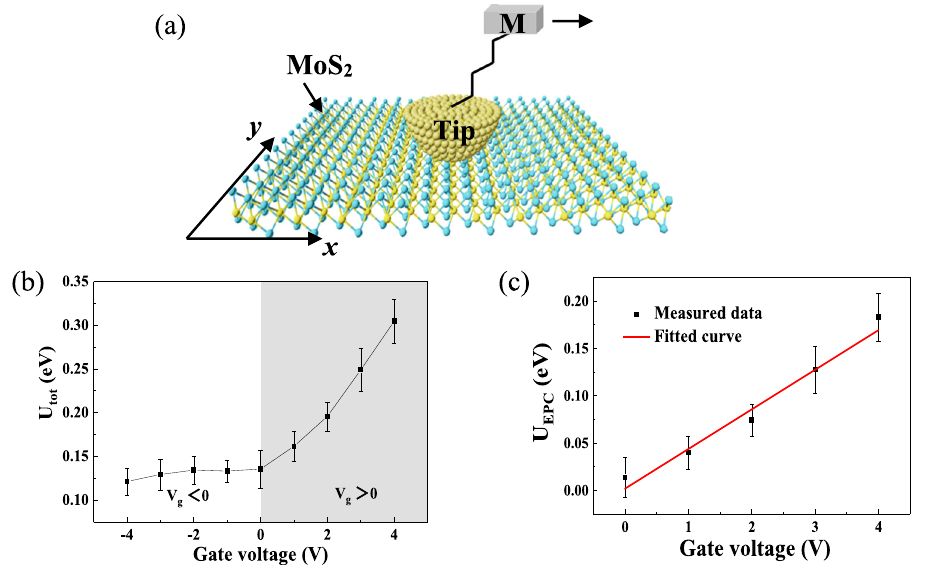
Fig. 7 Modi fi ed Prandtl − Tomlinson model and calculating of the energy corrugation. a Schematic of the modi fi ed Prandtl − Tomlinson model describing that the AFM tip moves on the monolayer MoS 2 . b Energy corrugation U tot as a function of gate voltage. c Energy corrugation U EPC of electronic friction as a function of gate voltage. Error bars represent standard